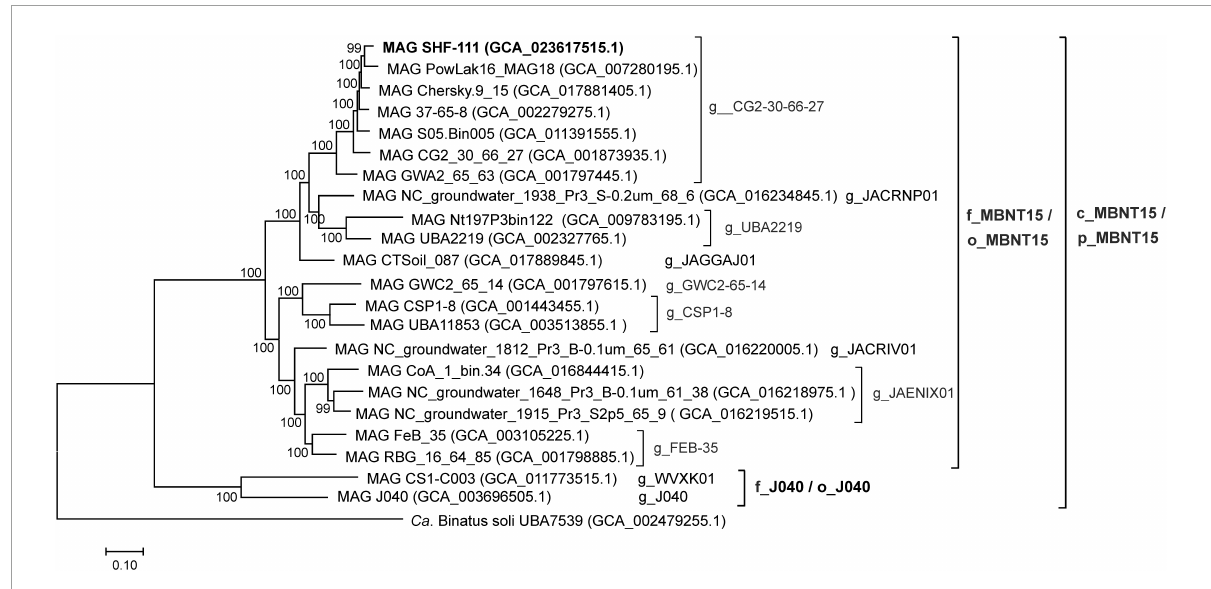
FIGURE2 Genome-based phylogeny of the candidate phylum MBNT15. Taxonomy is shown according to the GTDB (p,_phylum; c_class; o_order; f_,family; and g_,genus). The genome sequence of “ Candidatus Binatus soli”, a member of the sister candidate phylum Binatota (UBP10), was used to root the